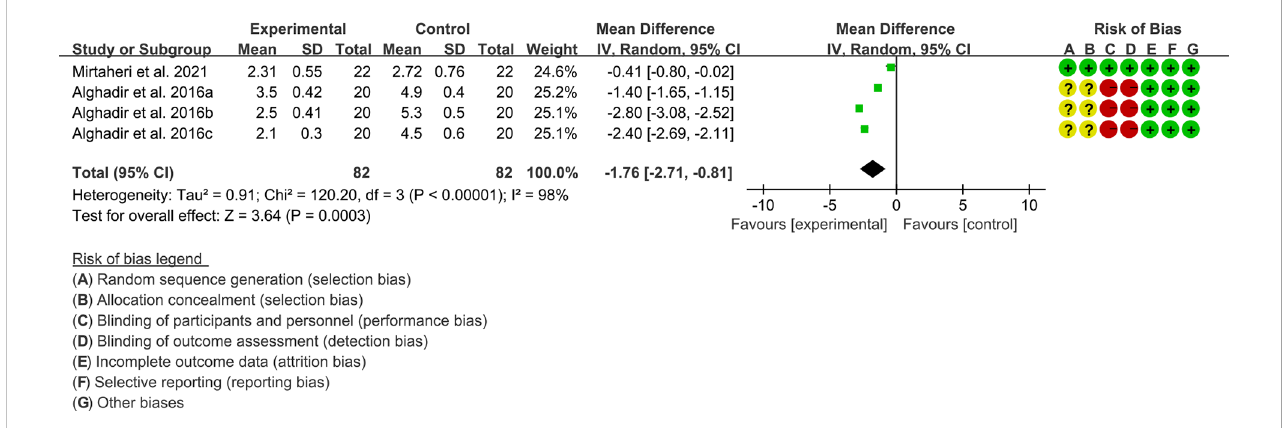
FIGURE 6 DAS28 in Tea